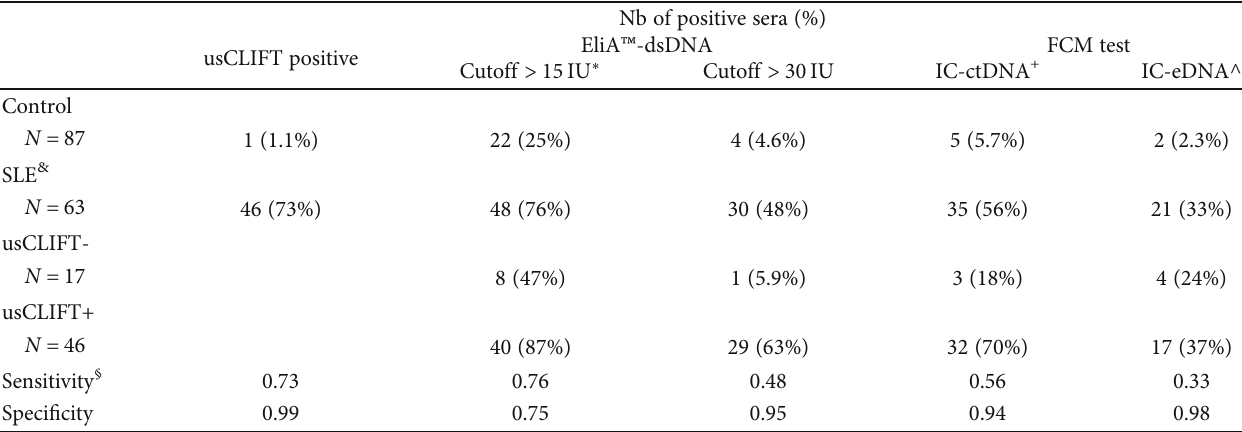
Table 1: Clinical sensitivity and speci fi city of anti-dsDNA detection tests in a cross-sectional analyses. 63 serum samples of SLE are classi fi ed according to the results observed on the usCLIFT.